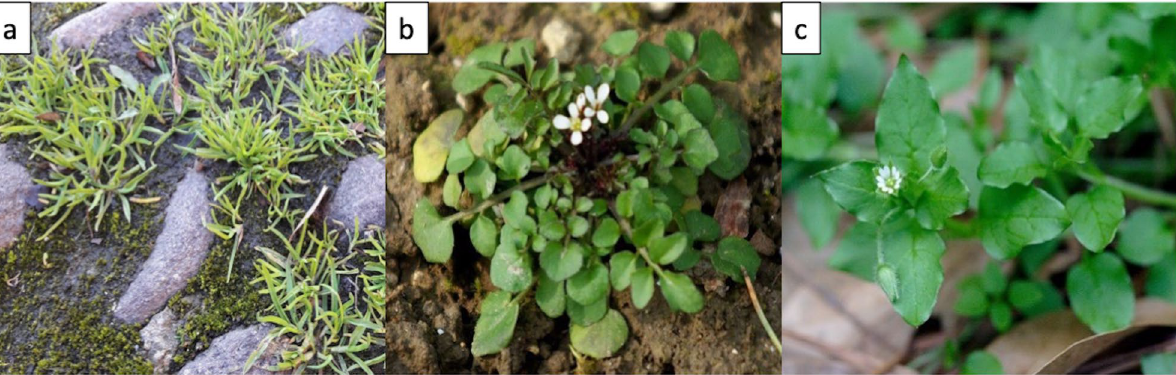
Figure 1. The three species used in the present study: ( a ) Poa annua L., ( b ) Cardamine hirsuta L., ( c ) Stellaria media (L.) Vill. Photographs by M.